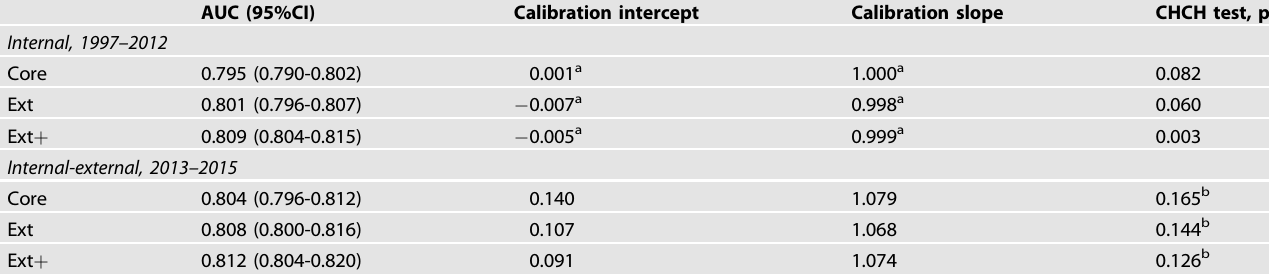
Table 3. Performance within internal and internal-external validation, including recalibrated intercept and slope of the three